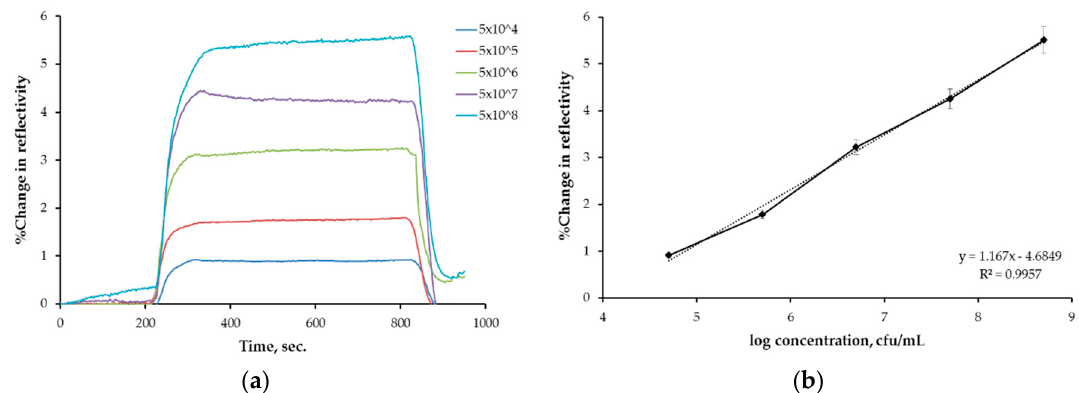
Figure 5. Concentration response results: ( a ) Sensorgram and ( b ) calibration curve.